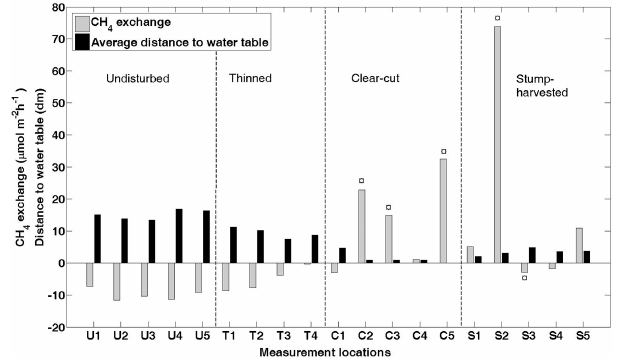
Figure 5. Correlation between CH 4 exchange (µmolm − 2 h − 1 ) and soil temperature ( ◦ C) at measurement location U 4 . The different colours represent different soil moisture and water table